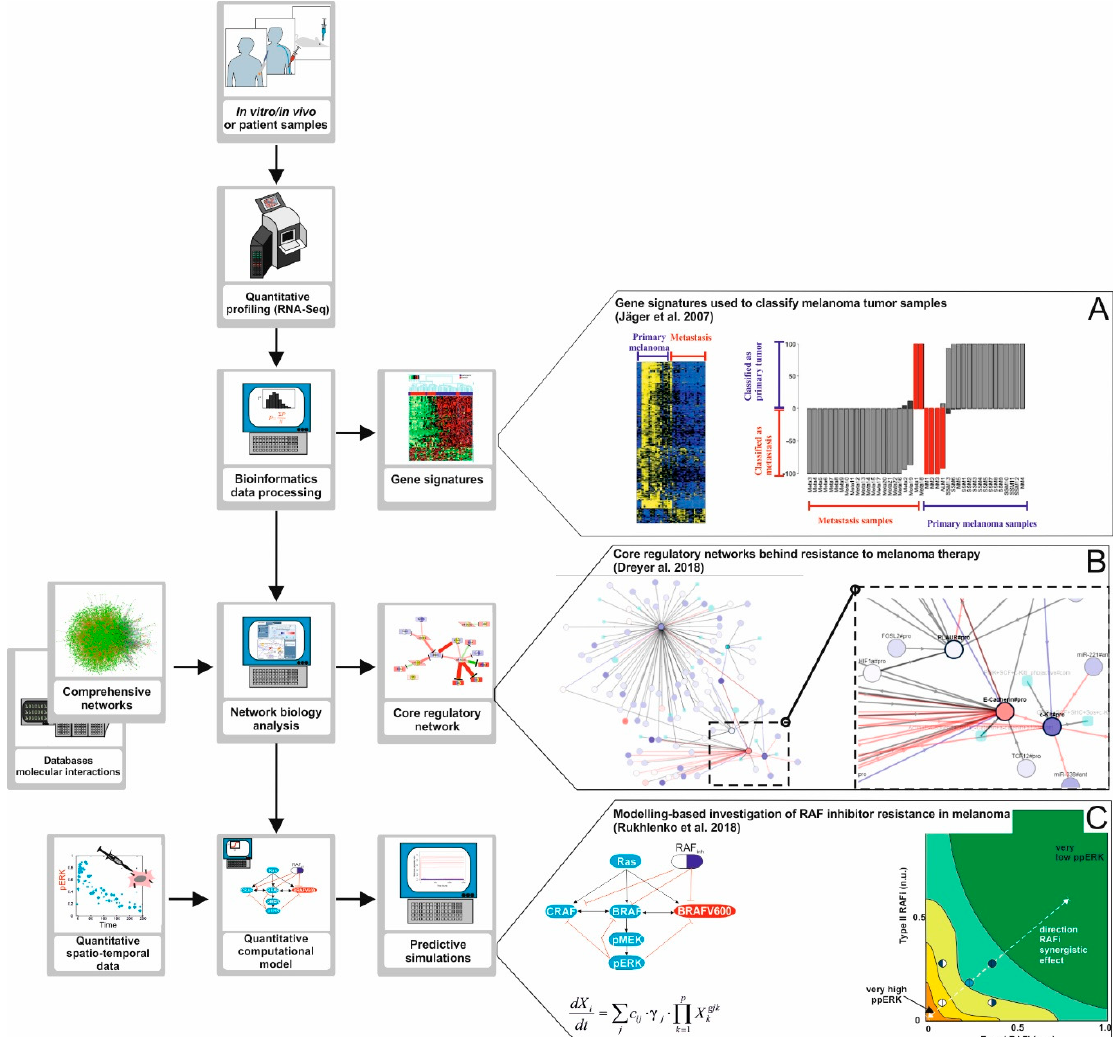
Figure 3. A road map to apply Systems Biology approaches in melanoma research. The development of high-throughput data generation technologies like next-generation sequencing, proteomics, and phosphoproteomics opens opportunities to investigate the mechanisms of emergence for BRAF inhibitor therapy resistance in melanoma in depth. ( A ) High-throughput data analysis. The data obtained from the quantitative profiling of tumor samples can be processed and analyzed making use of bioinformatics pipelines and algorithms. Using this approach, one can discover gene signatures, that is, ensembles of genes collectively deregulated in tumor samples from a group of patients. In the study of Jäger and co-workers [62], tumor samples were profiled and the data obtained was used to find a predictive gene signature for metastatic melanoma. ( B ) Network Biology. The processed high-throughput data can also be analyzed using network biology approaches. In this case, the data are mapped into large molecular networks, and computational algorithms are used to detect core regulatory networks, highly interconnected fractions of larger networks that are differentially regulated in, for example, treatment responders versus non-responders. The core network, compared to a gene signature, gives additional information because it helps constructing hypotheses about the molecular mechanisms linking the differentially regulated genes. In a study by Dreyer and co-workers [66] we reconstructed a comprehensive network accounting for signaling pathways commonly deregulated in melanoma. The network was used to detect a core regulatory network discriminating responders from non-responders in a cohort or patients treated with anti-PD-1 immunotherapy. The comprehensive network derived is available at www.vcells.net/melanoma. ( C ) Computational modelling of regulatory pathways. High- throughput data, core regulatory networks, and additional quantitative data like drug dose response curves or time series of signal pathway